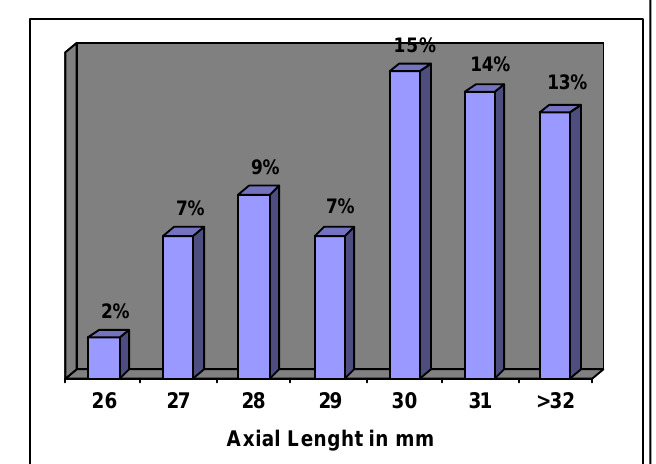
Fig. 2 : Prevalence of lattice degeneration by Kartin and